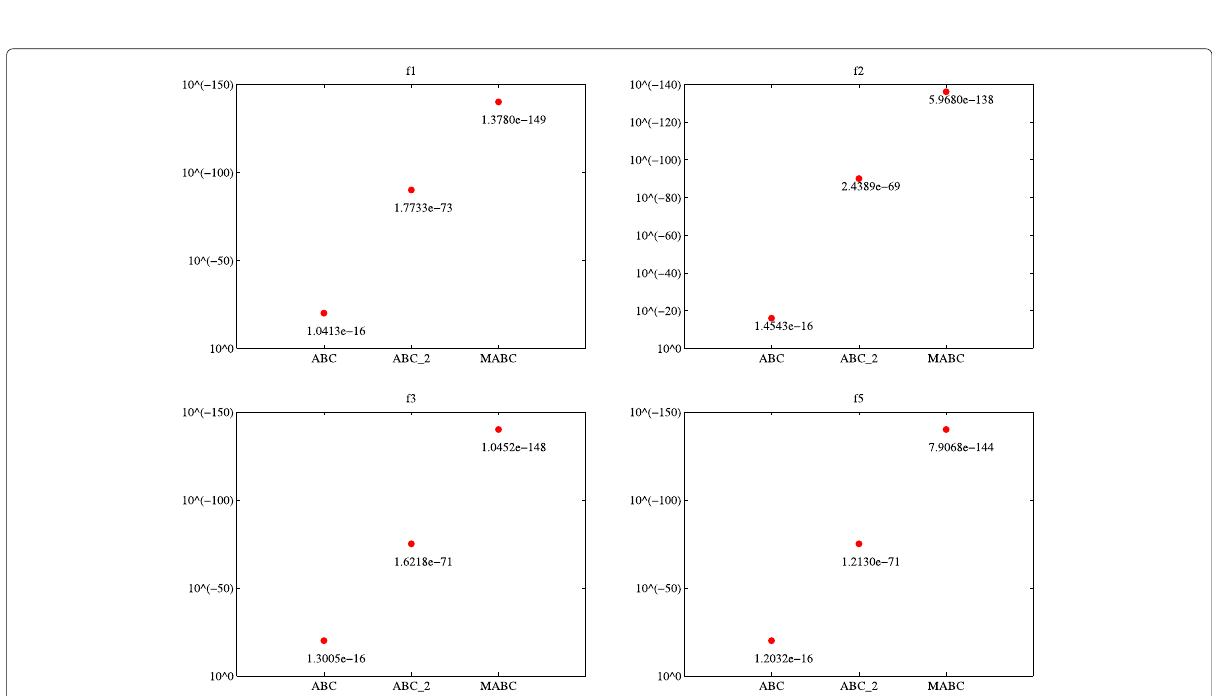
Fig. 5 Demonstration of the second modification’s